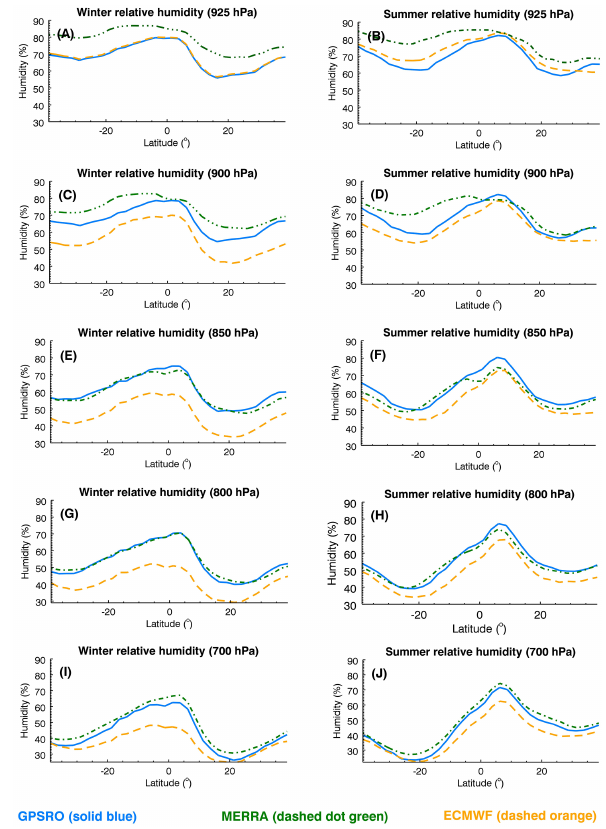
Figure 2. Boundary-layer zonal-mean moisture climatology during winter (DJF; left column) and summer (JJA; right column), aver- aged over the 2007–2009 period from GPSRO (solid blue) observa- tions and MERRA (dashed dot green) and ECMWF (dashed orange) reanalyses.